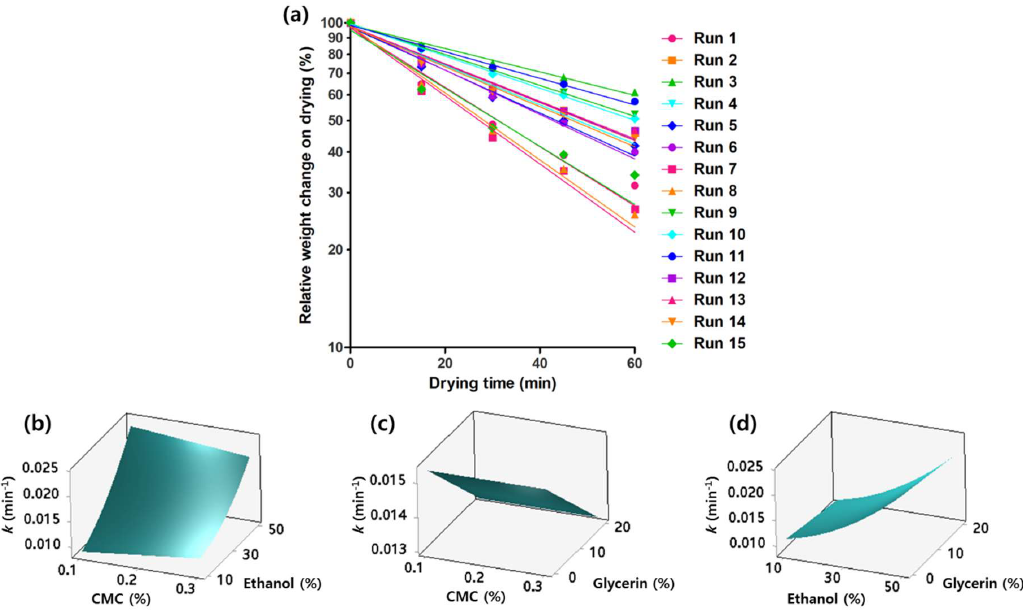
Figure 4. The weight loss of the hydrosol on drying ( a ). The best-fit straight line (first-order kinetics) for each run is shown together. Response surface plots exhibiting the effect of ( b ) CMC ( x 1 ) and ethanol ( x 2 ); ( c ) CMC ( x 1 ) and glycerin ( x 3 ); and ( d ) ethanol ( x 2 ) and glycerin ( x 3 ) on drying rate constant ( k ; y 2 ). The old values of CMC, ethanol, and glycerin were set at 0.2%, 30%, and 10%, respectively.